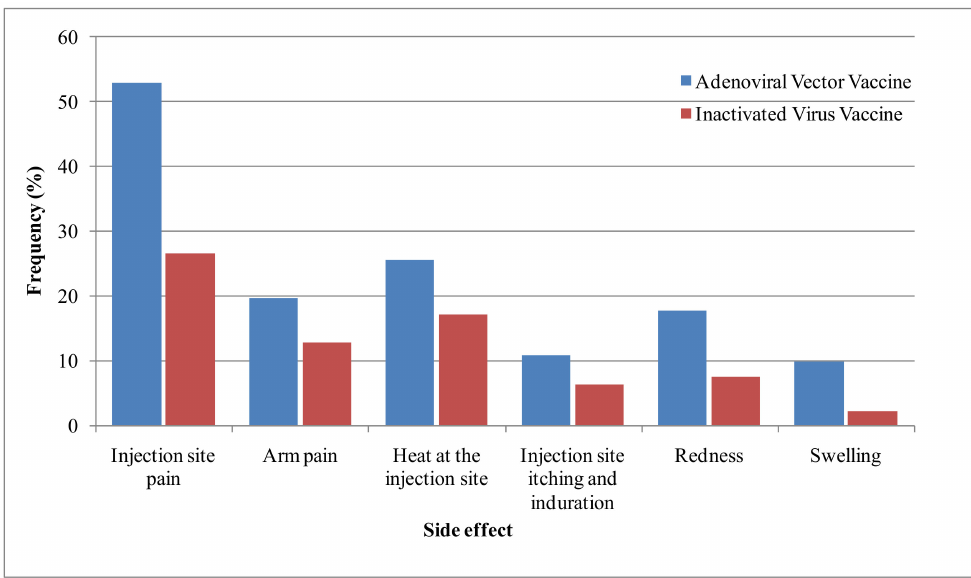
Figure 1. Frequency of local side effects reported by the studied population.